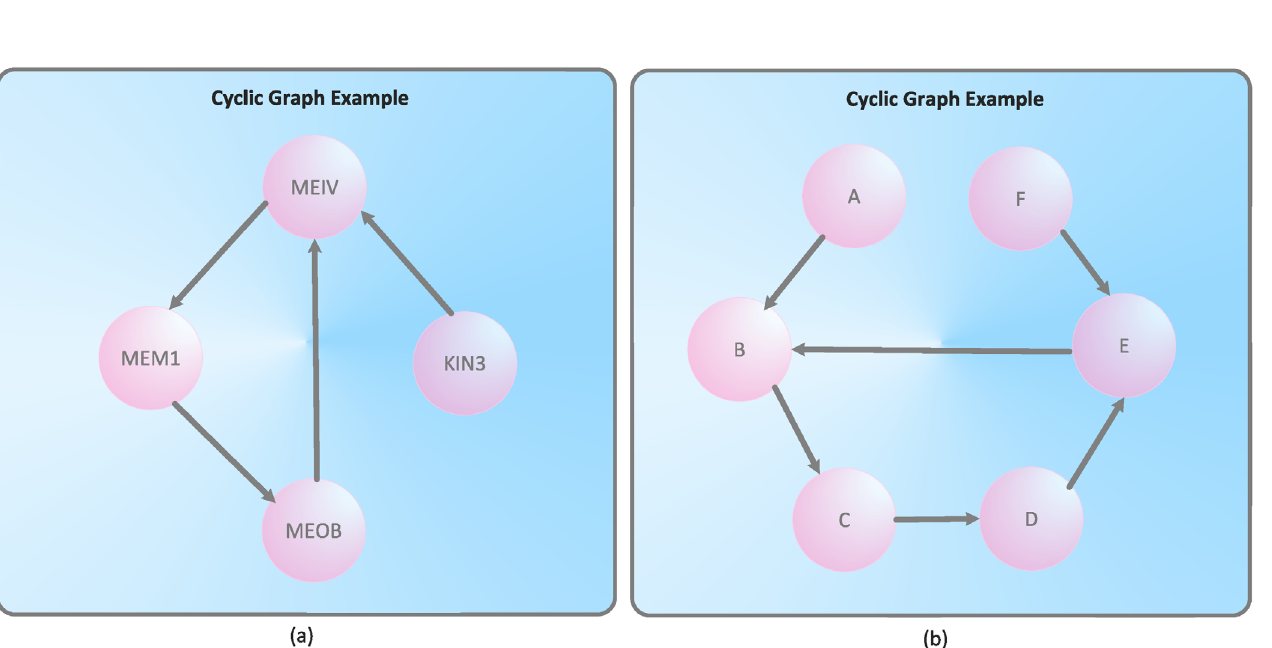
Fig 5. Examples of the cyclic treatment cycles.